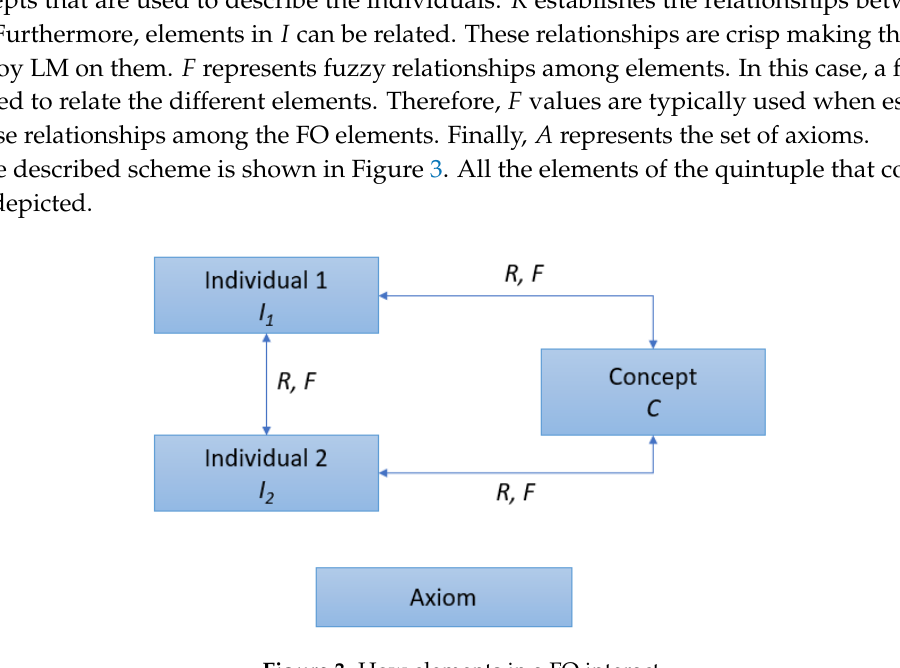
Figure 3. How elements in a FO